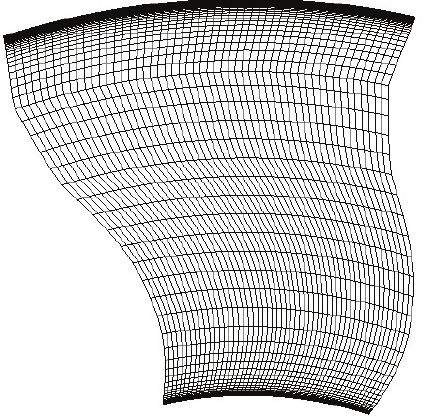
Figure 14: Axial cut of computational mesh for the axial rotor subdomain.